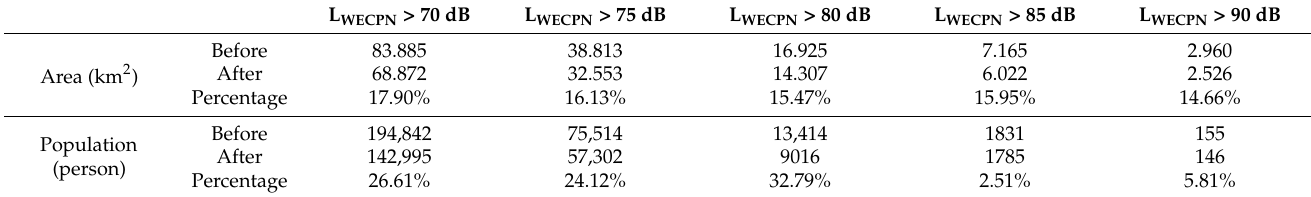
Table 2. Noise reduction effects due to aircraft type optimization during summer.